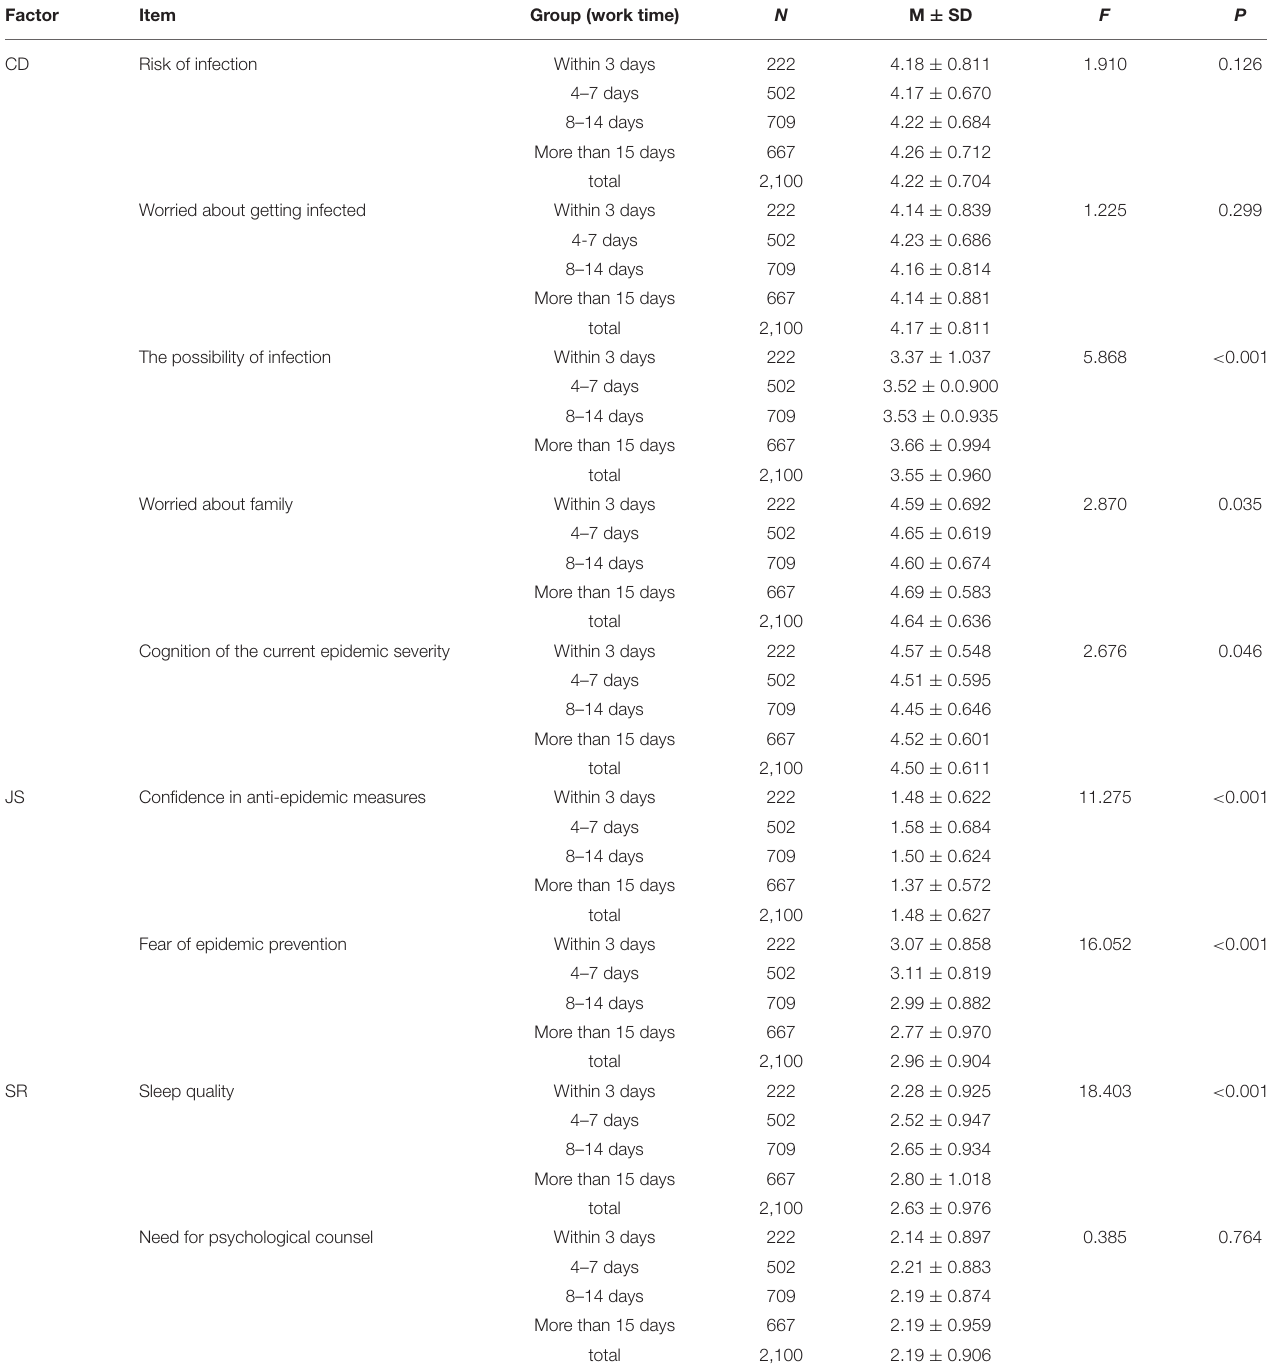
TABLE 6 | Differences in the length of work.